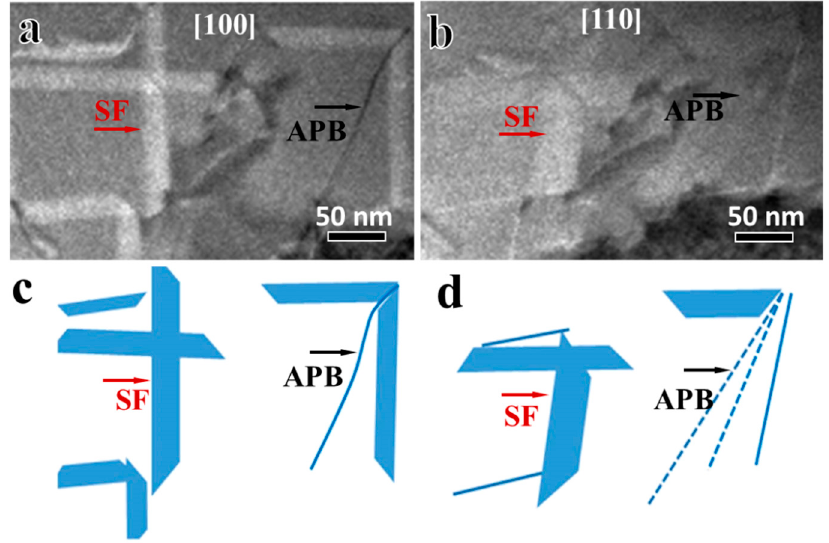
Figure 5. Tilted transmission electron microscopy (TEM) images contains typical SFs and APBs viewed along ( a , c ) the [100] direction and ( b , d ) [110] direction.